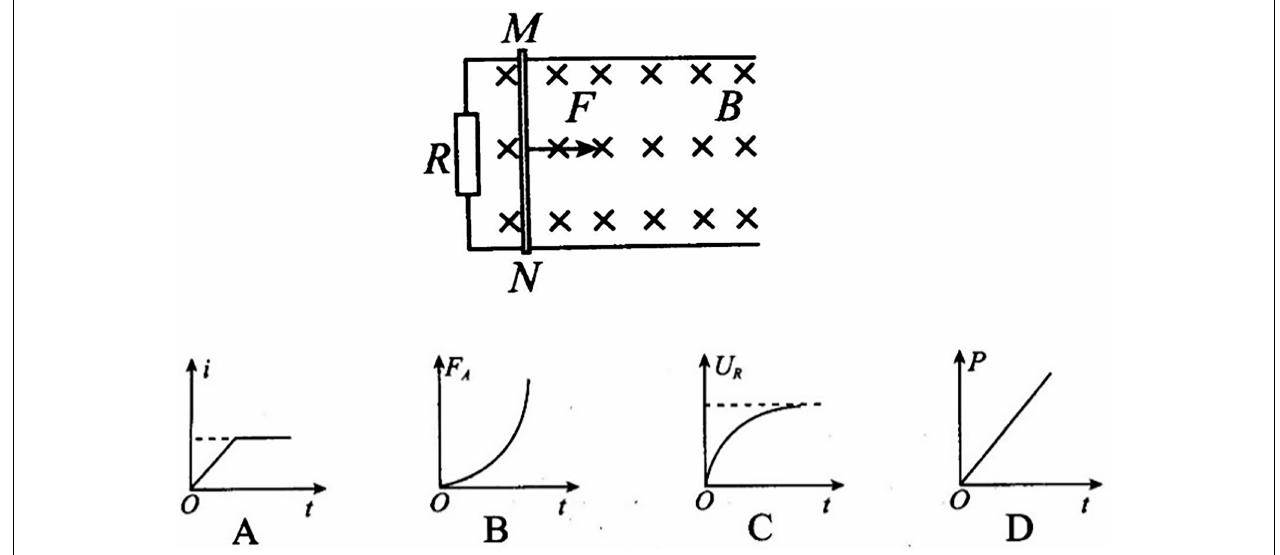
FIGURE 3 | The circuit and options of example question that examines the attribute “Faraday’s law: integrated application.”